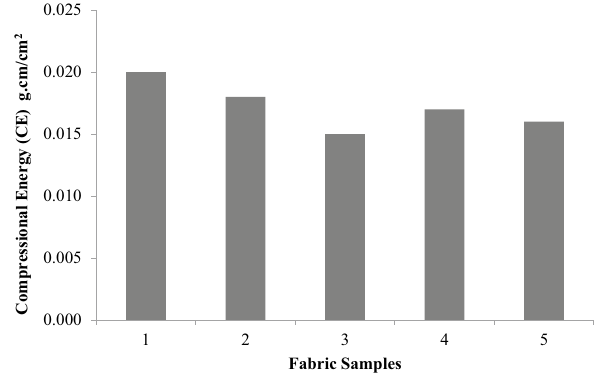
Figure 14. Compressional energy (CE) of fabrics.